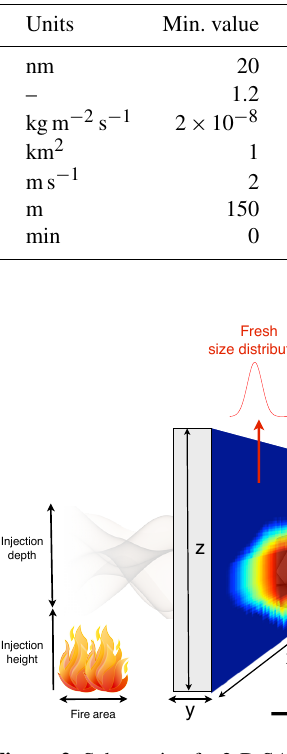
Figure 2. Schematic of a 2-D SAM-TOMAS plume